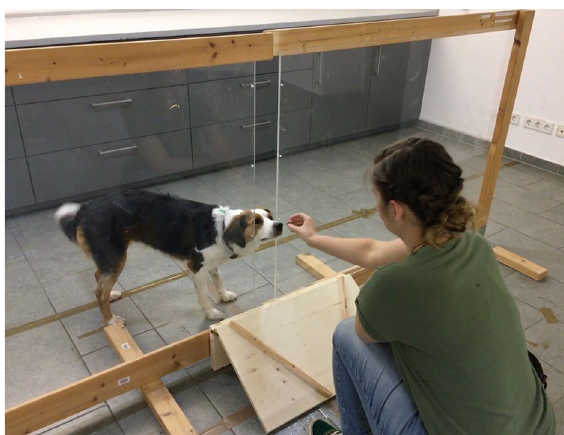
Figure 1. Experimental set-up with opened gap.